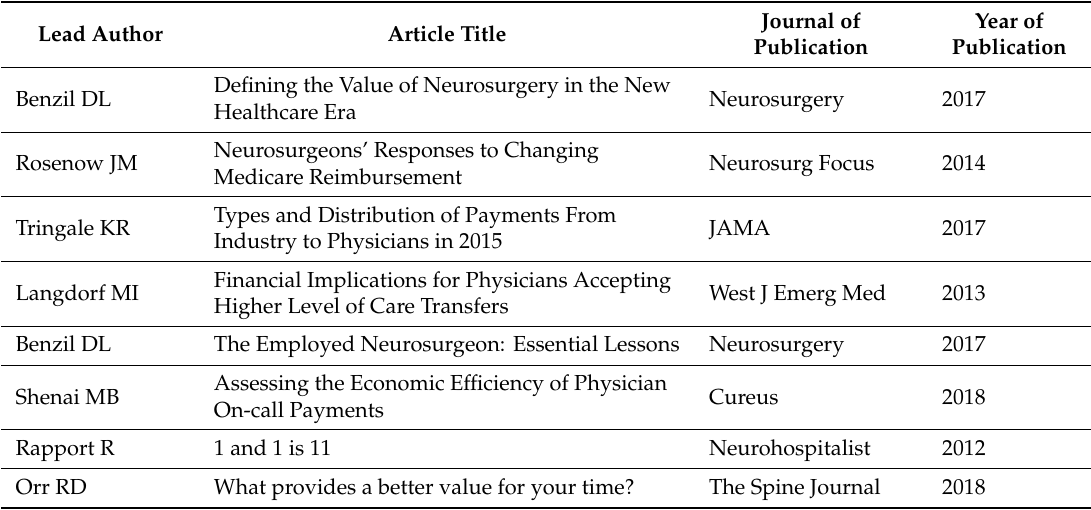
Table 1. Full-length Articles Considered for Analysis.